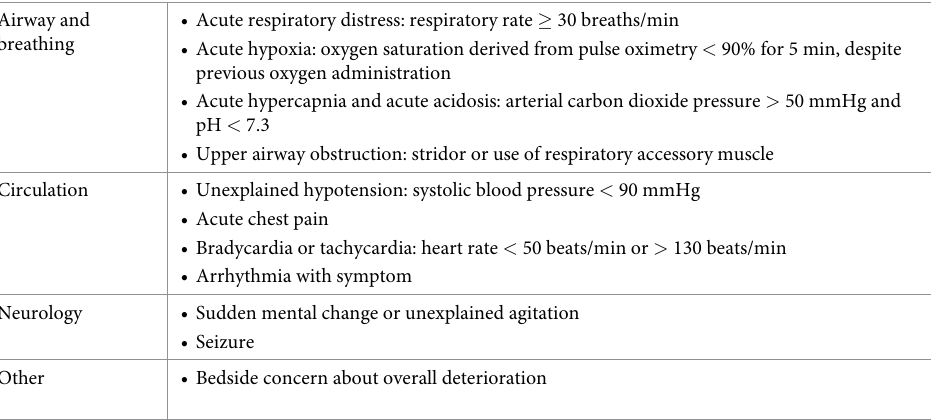
Table 1. Calling criteria for the medical emergency